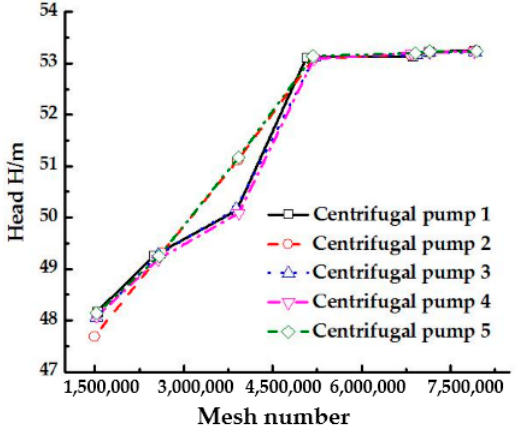
Figure 9. Meshes independence.